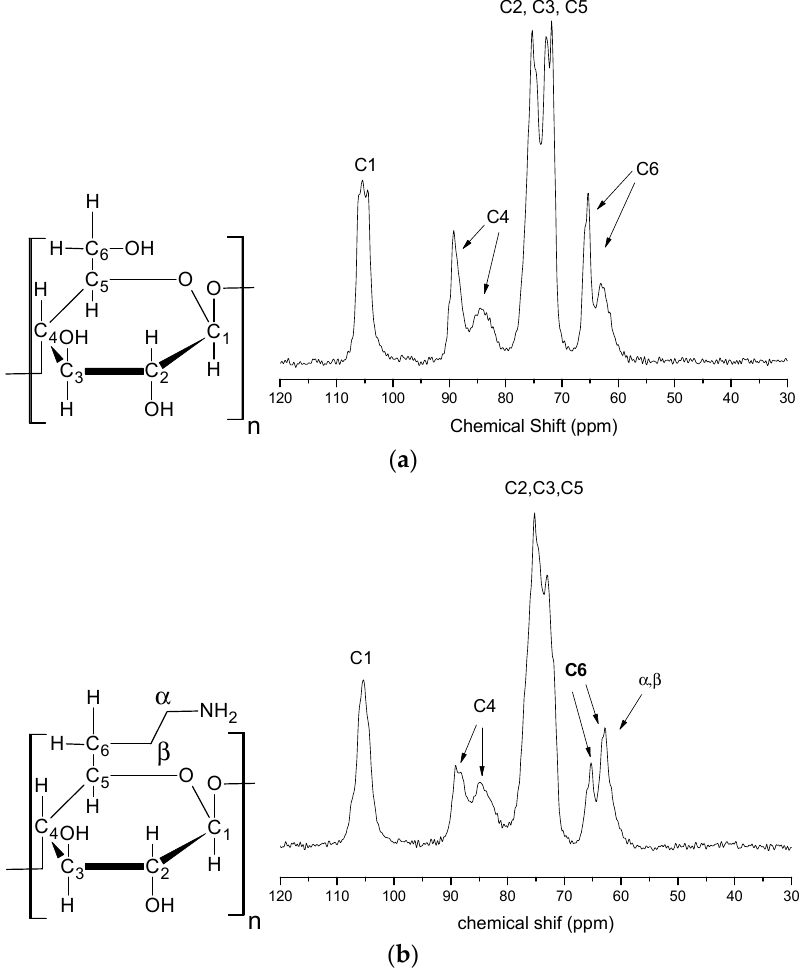
Figure 4. Solid state 13 C-NMR spectra of pristine microcrystalline cellulose ( a ) and CN polymer ( b ).